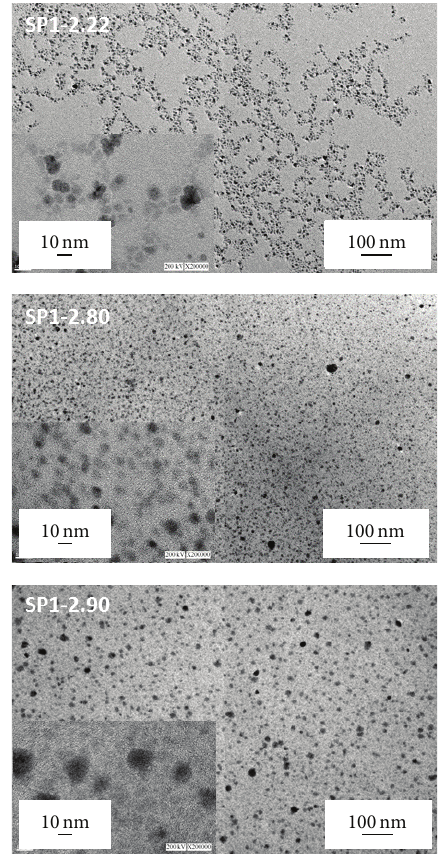
Figure 7: TEM image of SP1-2.22, SP-2.80, and SP1-2.90 mem-